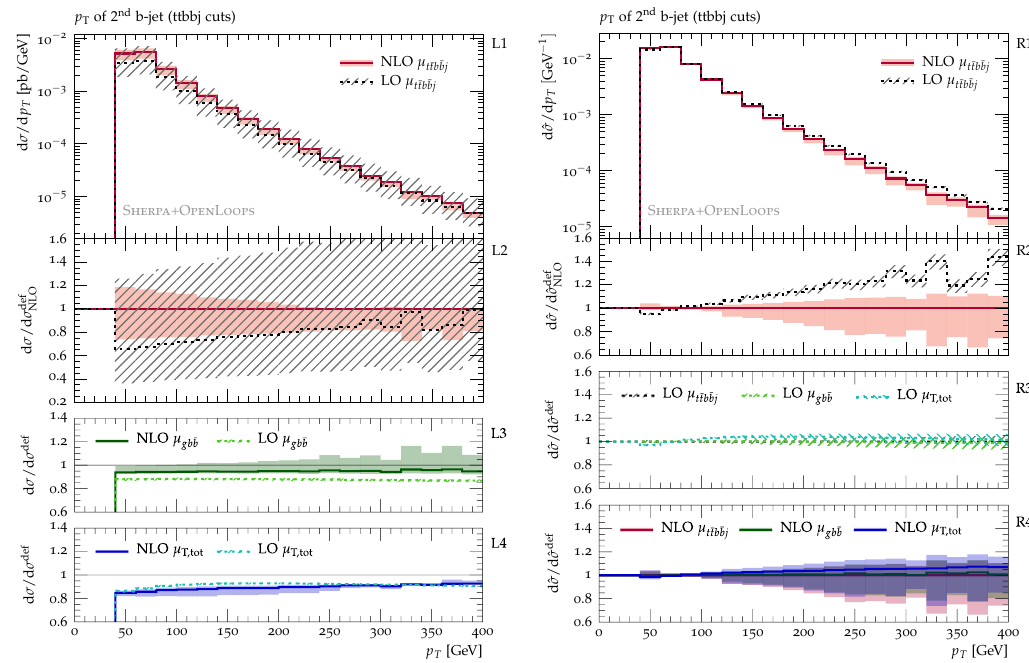
Figure 14. p T of the second b -jet. Same setup and plots as in (cid:12)gure